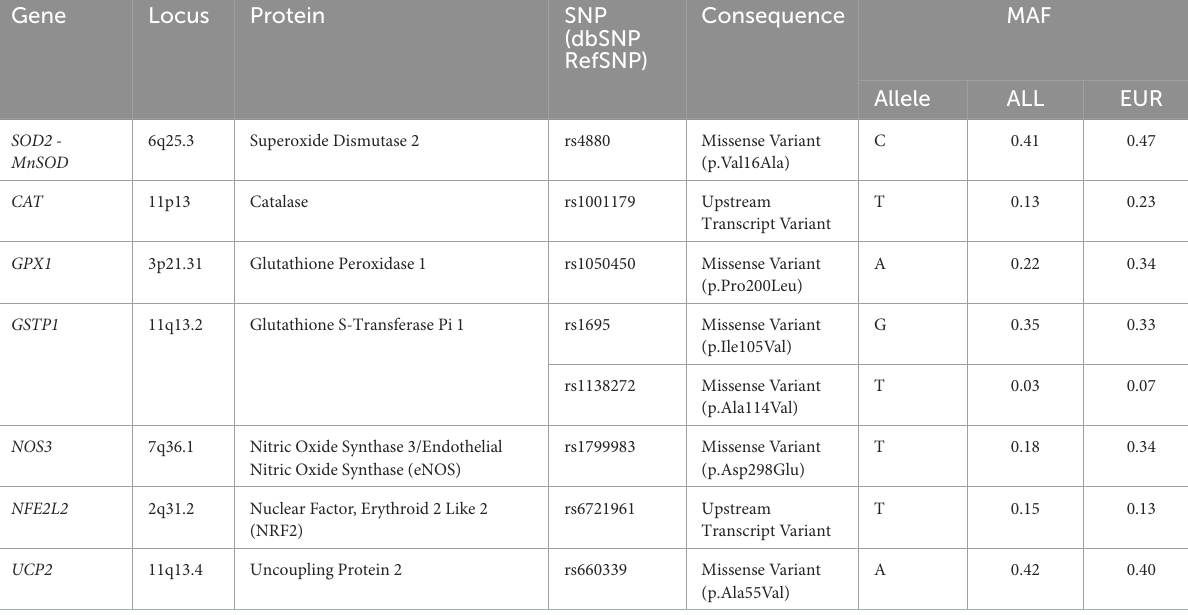
TABLE 1 Summary of the investigated oxidative stress-related SNPs. Gene Locus